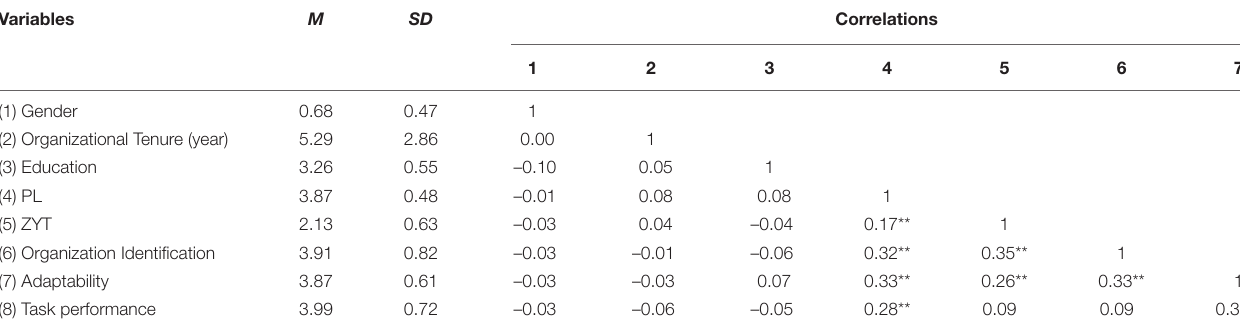
TABLE 3 | Descriptive statistics and correlation coefficient matrix.